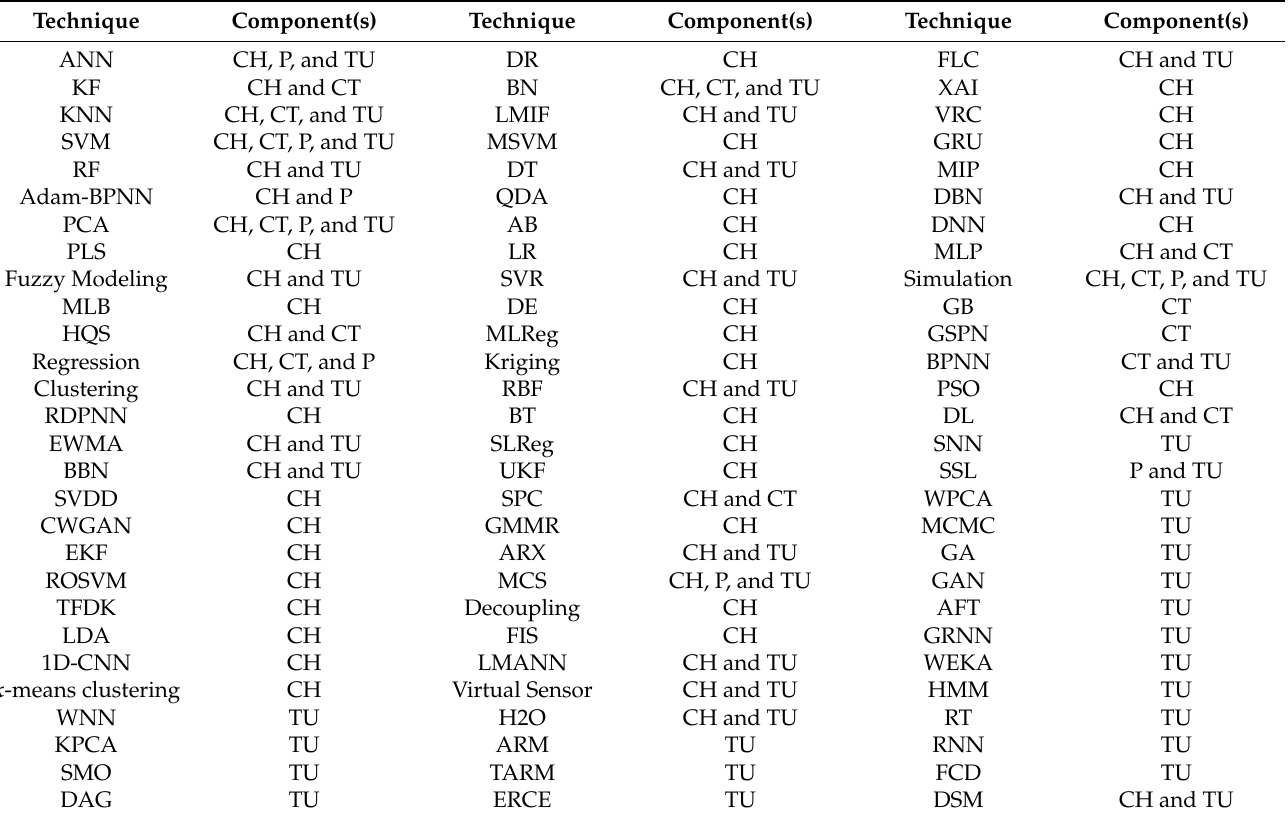
Table 4. Summary of CWS’s PdM tools across the literature (chiller, CH; cooling tower, CT; pump, P; terminal unit,